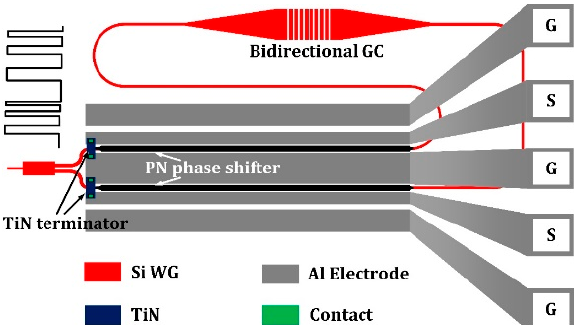
Figure 4. Schematic of demonstrated ultrawide misalignment tolerance modulator with bidirectional grating